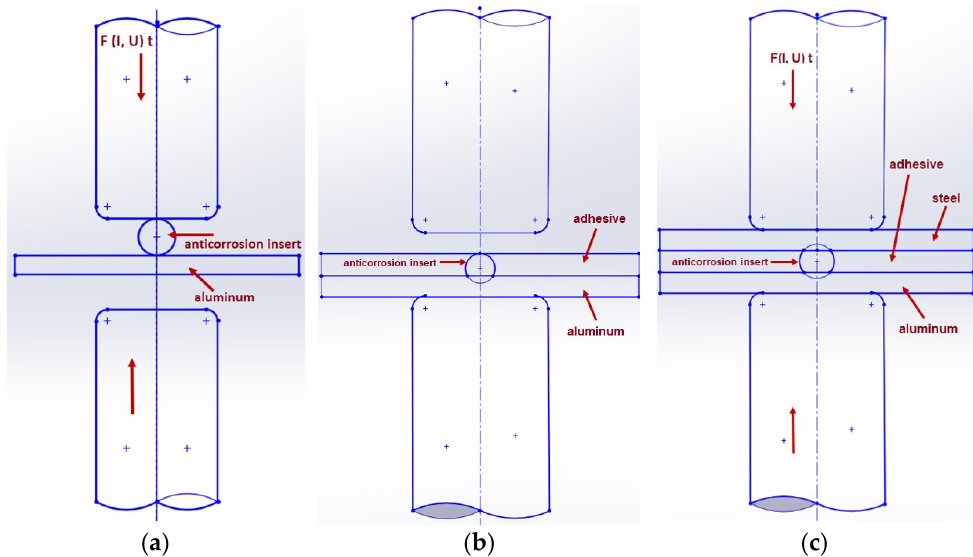
Figure 2. Schematic representation of joint formation by resistance spot welding: ( a ) welding of in- sert element to aluminum and ( b ) welding of steel plate to insert–aluminum joint.